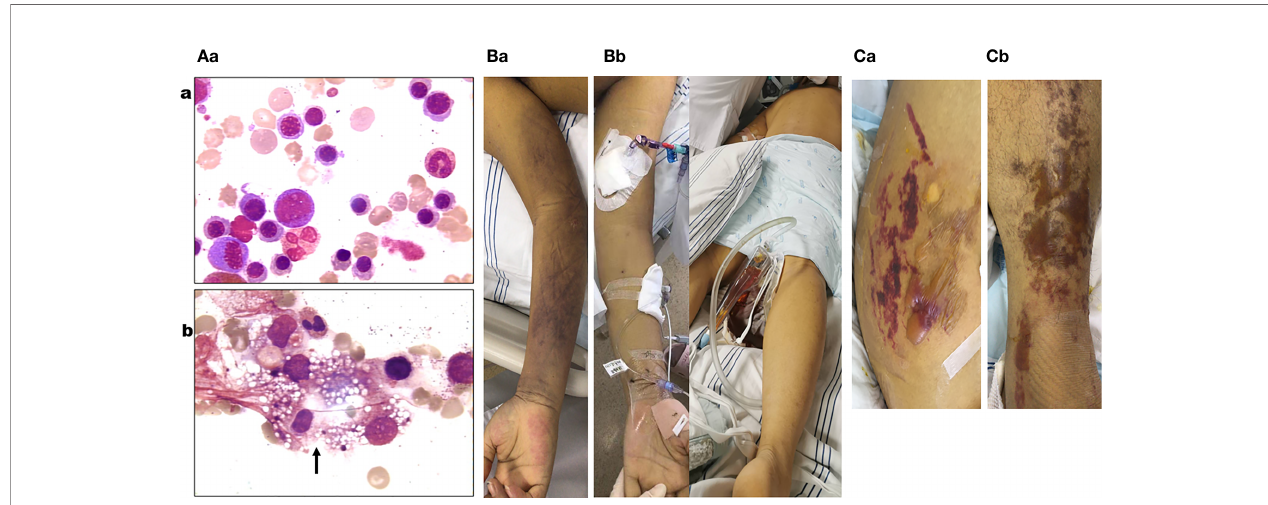
FIGURE 2 | (Aa) Blue – purple ecchymosis on the proximal right upper limb of the patient when being transferred to medical intensive care unit (MICU). (Ab) Blue – purple ecchymosis did not appear on his trunk, lower limbs, and upper left limb at that time. (Ba) Strained blisters fi lled with serous fl uids on predominantly erythematous skin on his torso ( Ba ; buttocks as a representative) and limbs [ (Bb) ; left limb as a representative] on the tenth day in MICU. (Ca) Bone marrow examination on the fourth day of admission (smear; ×400) revealed active bone marrow hyperplasia; a signi fi cant increase of red blood cells (RBCs) (52.25%) of which the middle and late stages of RBC account for a large proportion; no obvious abnormalities of granulocytes; lymph proportion was reduced with the morphology roughly normal; platelets were signi fi cantly reduced and distributed in single or clusters, with no clue to acute aplastic crisis or hemophagocytic syndrome. (Cb) Bone marrow examination on the second day in MICU (smear; ×400) revealed a marked decrease in the density of erythroblasts, inhibition of megakaryocyte maturation, and easily seen phagocytes containing vacuoles, platelets, impurities, and other components (black